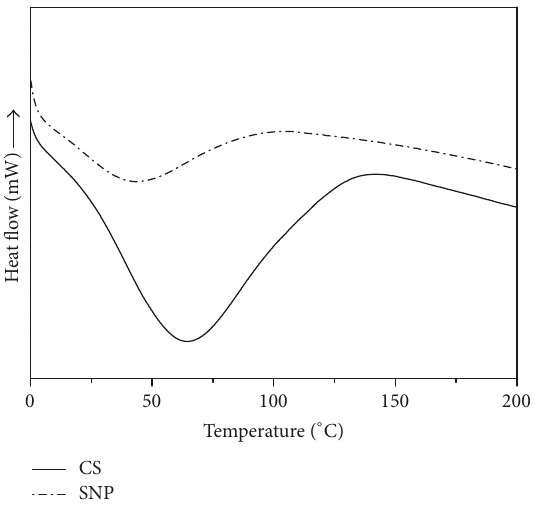
Figure 7: Differential thermal analysis of cassava starch (CS) and starch nanoparticles (SNP).